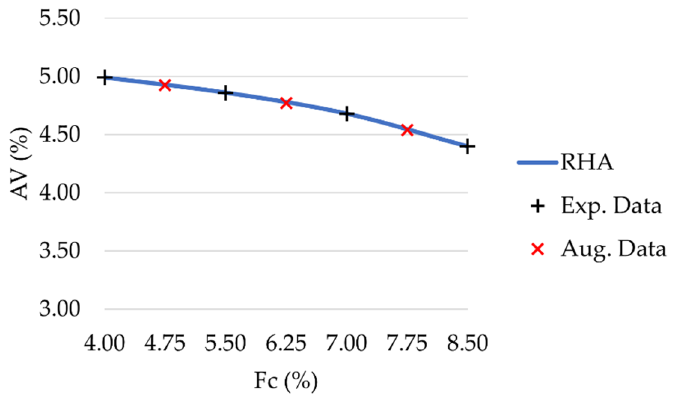
Figure 3. Experimental data (black plus sign marker) and augmented data (red cross marker) for RHA mixtures.